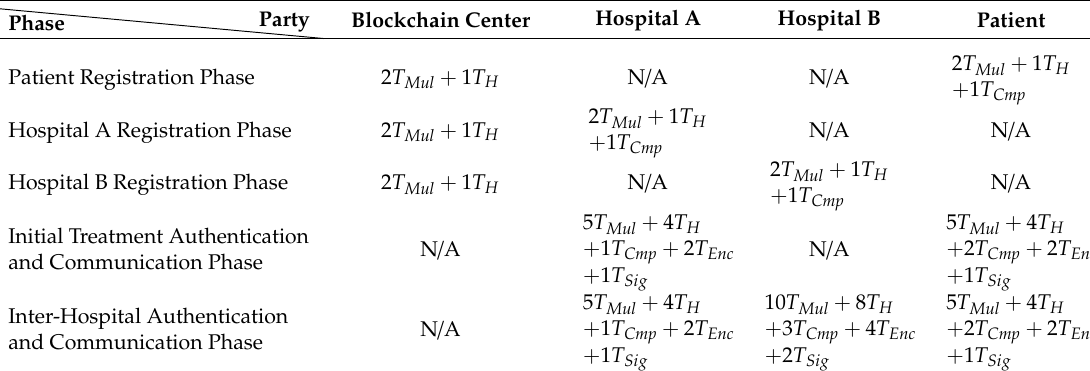
Table 2. The computation costs of the proposed scheme.